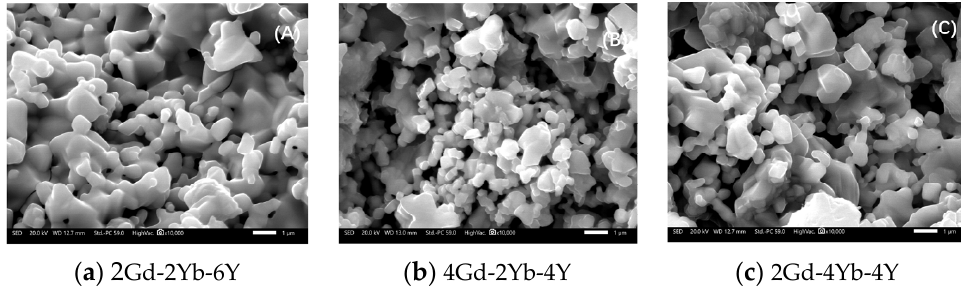
Figure 4. Microstructure of different component powders after 150 h at 1300 ◦ C.